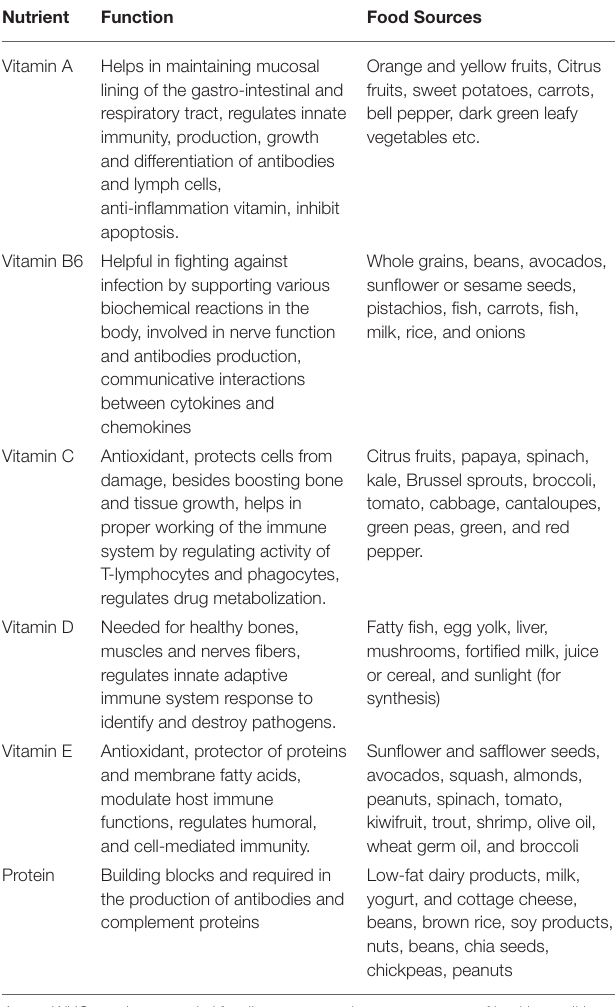
TABLE 2 | Functions of immunity building nutrients in the human body along with their food sources. Nutrient Function Food